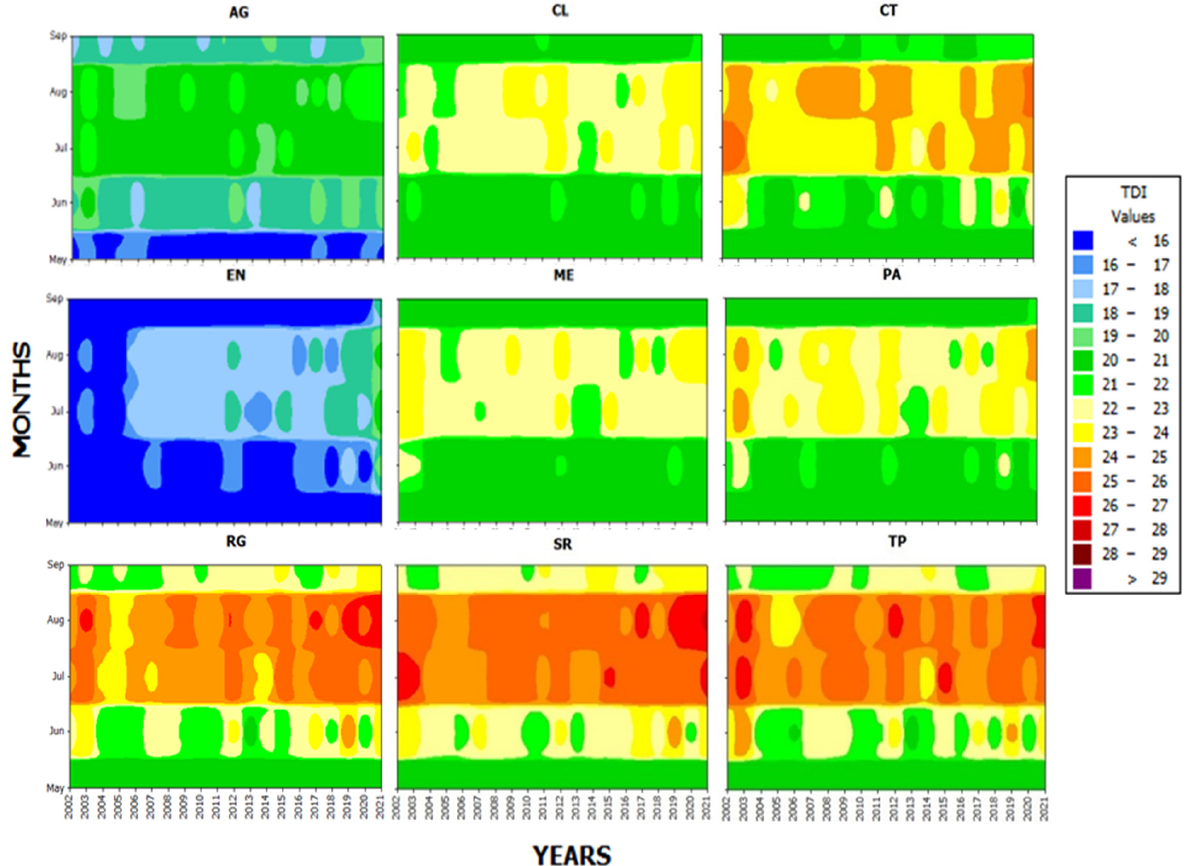
Figure 2. Contour plot of the TDI value as a function of the months and years of each province.